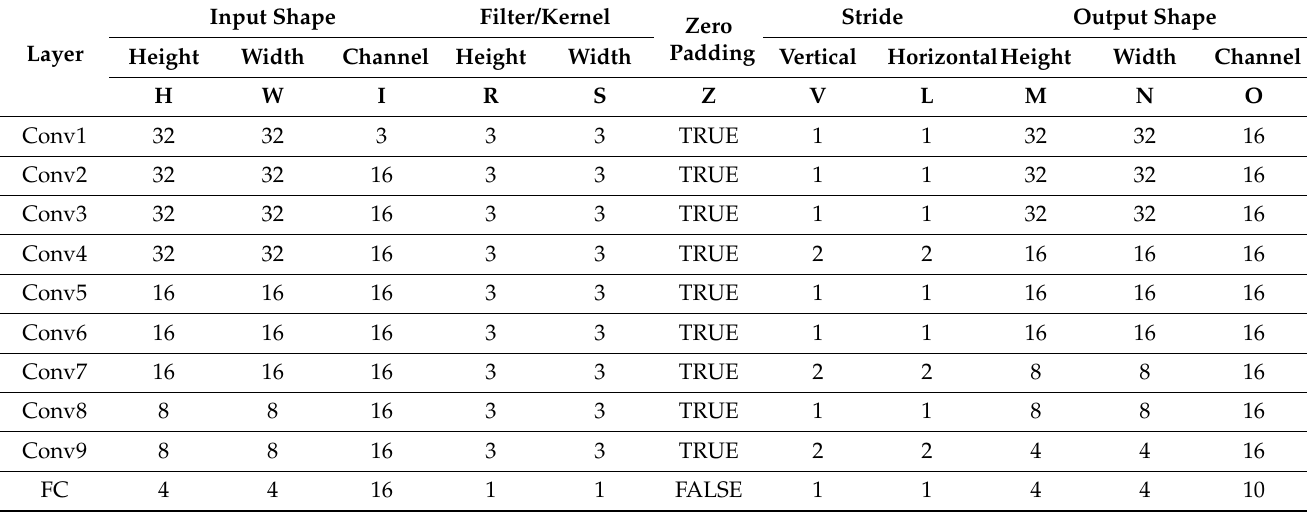
Table 1. Network parameters using the configuration of 9 CNNs and 1 FC